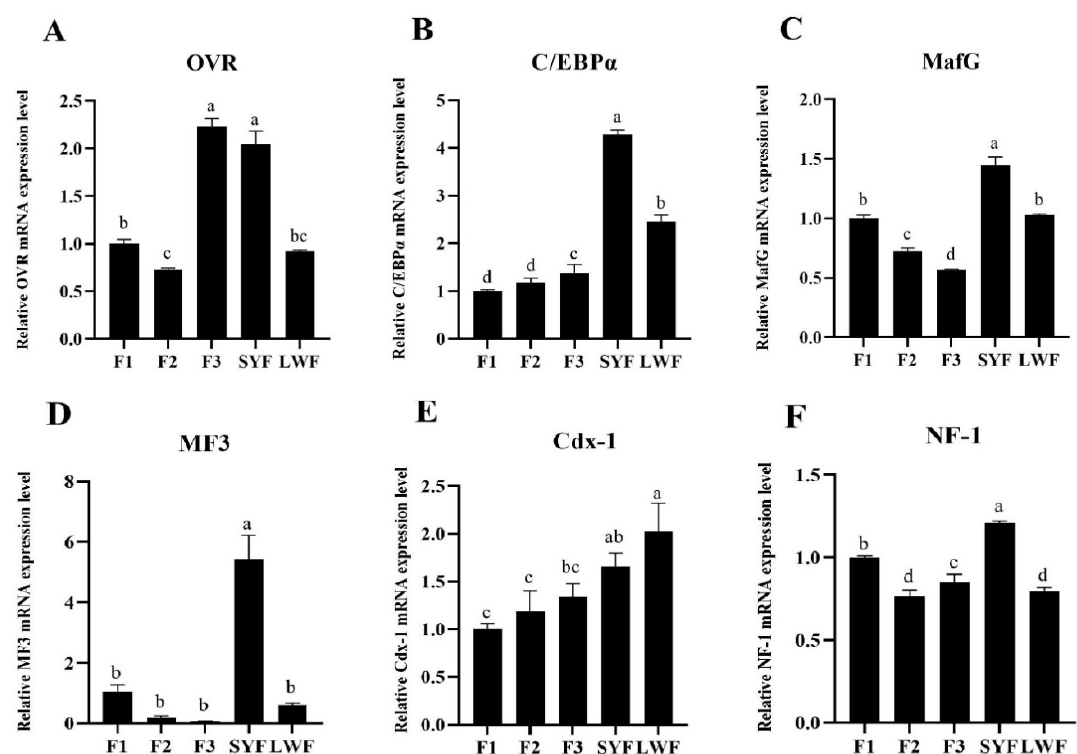
Figure 3. The expression of oocyte vitellogenesis receptor (OVR) and transcription factors at the granular layer in different follicle levels of Wanxi White goose. ( A ): Relative OVR mRNA expression level. ( B ): Relative C/EBP α mRNA expression level. ( C ): Relative MafG mRNA expression level. ( D ):